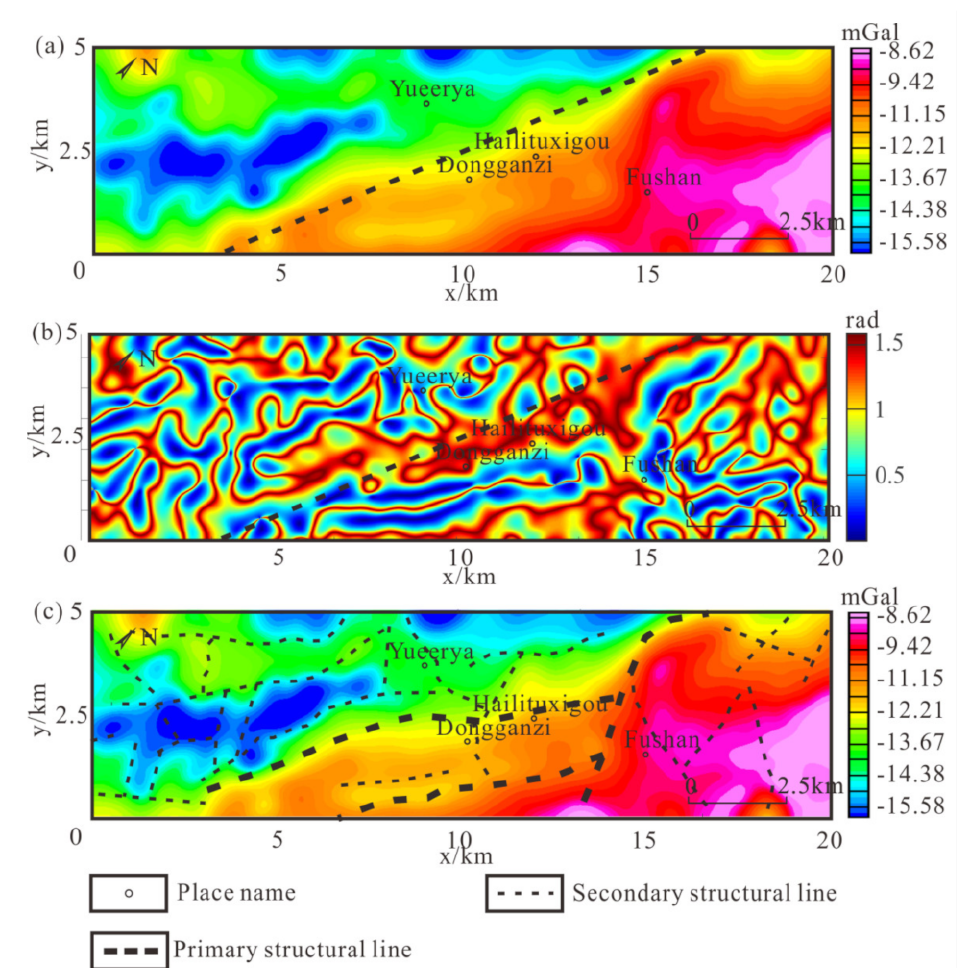
Figure 9. Structure division of the study area: ( a ) Regional anomaly of the study area; ( b ) the SD result; ( c ) the result of structure